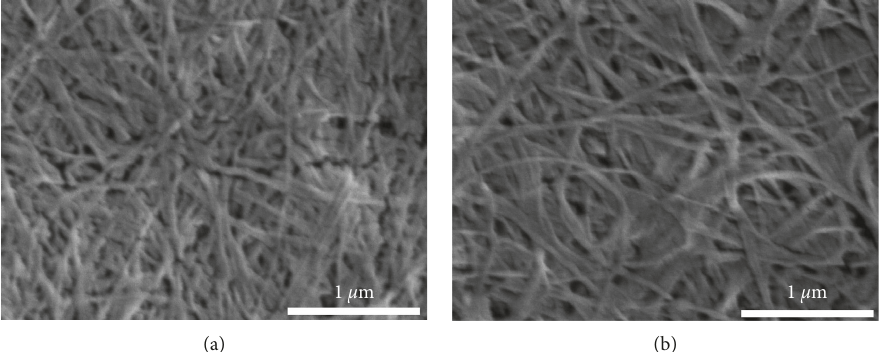
Figure 9: 35k magnification of SEM images of (a) DNDC (A0) and (b) OC-24 hrs